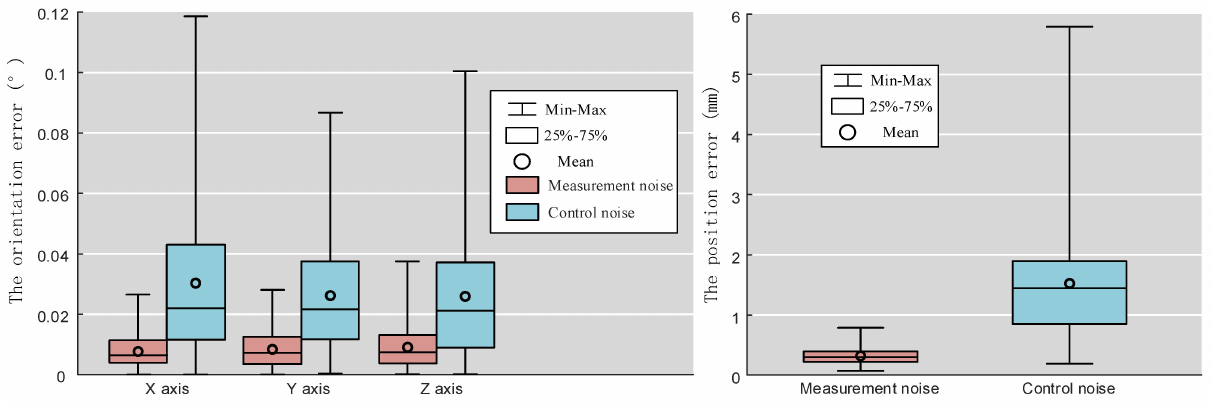
Figure 6. Kinematics simulation of measurement noise and control